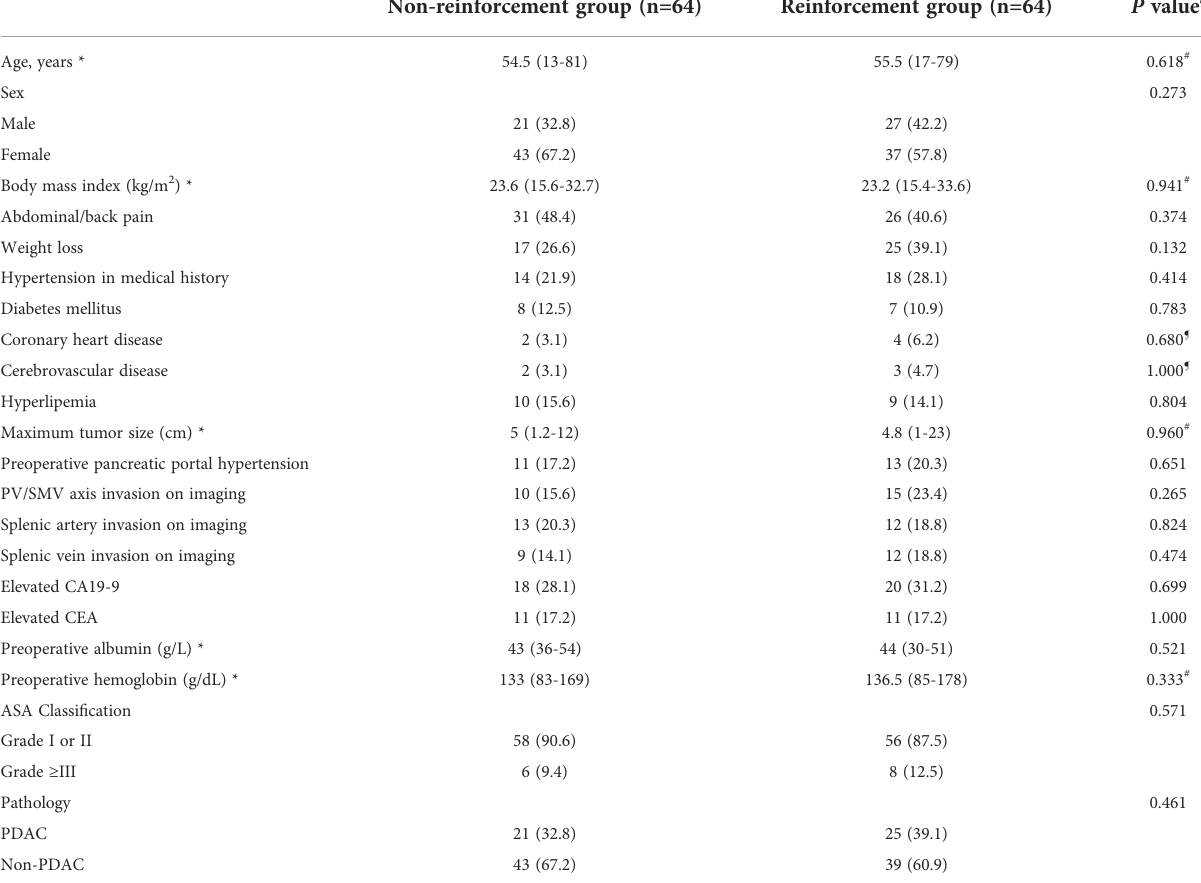
TABLE 2 Comparison of baseline and clinicopathological characteristics of patients between the